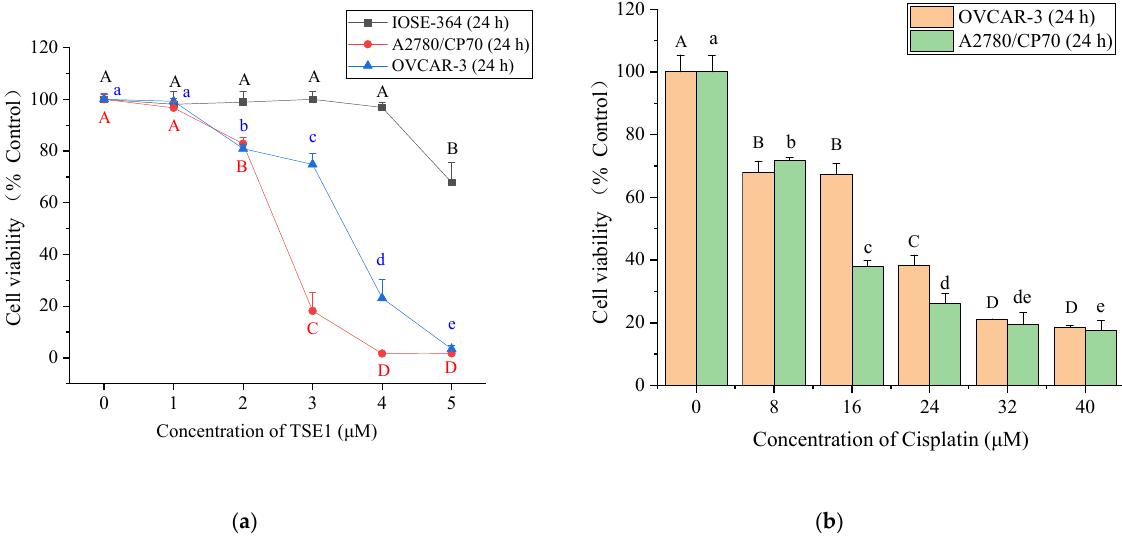
Figure 1. Effect of Theasaponin E 1 (TSE1) and cisplatin on cell viability at 24 h. ( a ) TSE1 cytotoxicity effects in OVCAR-3, A2780/CP70 and IOSE-364 cells. ( b ) Cisplatin cytotoxicity in OVCAR-3 and A2780/CP70 cells. Cell viability was determined by the 3-(4,5-dimethylthiazol-2-yl)-5-(3-carboxymethonyphenol)-2-(4-sulfophenyl)-2 H -tetrazolium (MTS) assay. Data represent means ± SD from three independent experiments. Significant differences among different treatments are indicated by different letters ( p <